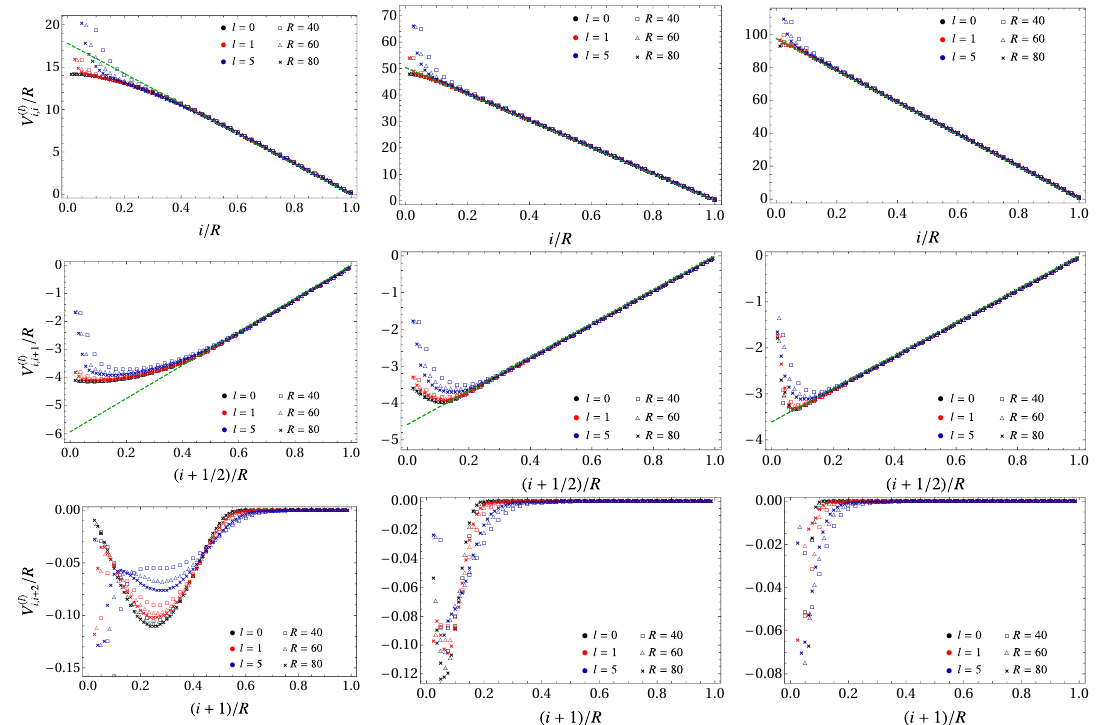
Figure 9. Short-range couplings in the matrices V ( l ) /R (see (3.2) and (3.5)) when ω > 0 and d = 3 , for ω = 1 (left panels), ω = 3 (middle panels) and ω = 5 (right panels), for some l ’s and different R . The dashed green lines in the top and middle panels correspond to